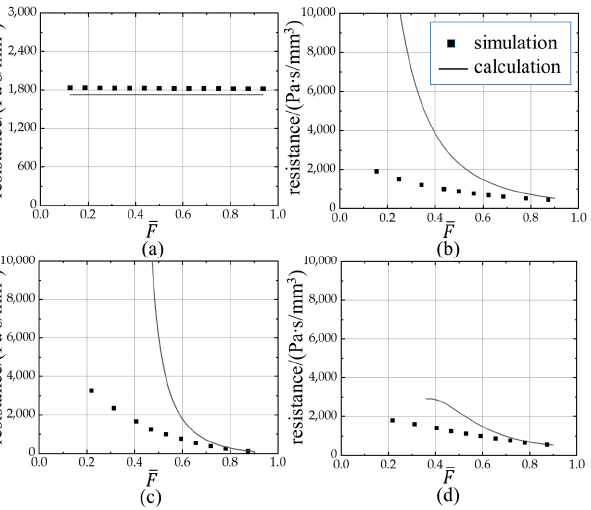
Figure 12. Simulation results of the flow resistance of the three types of restrictors. ( a ) Capillary restrictor; ( b ) single-action membrane restrictor without pre-pressure; ( c ) The gap between the membrane and the cylindrical sill for PSMR; ( d ) Pre-pressure single-action membrane-type restrictor.